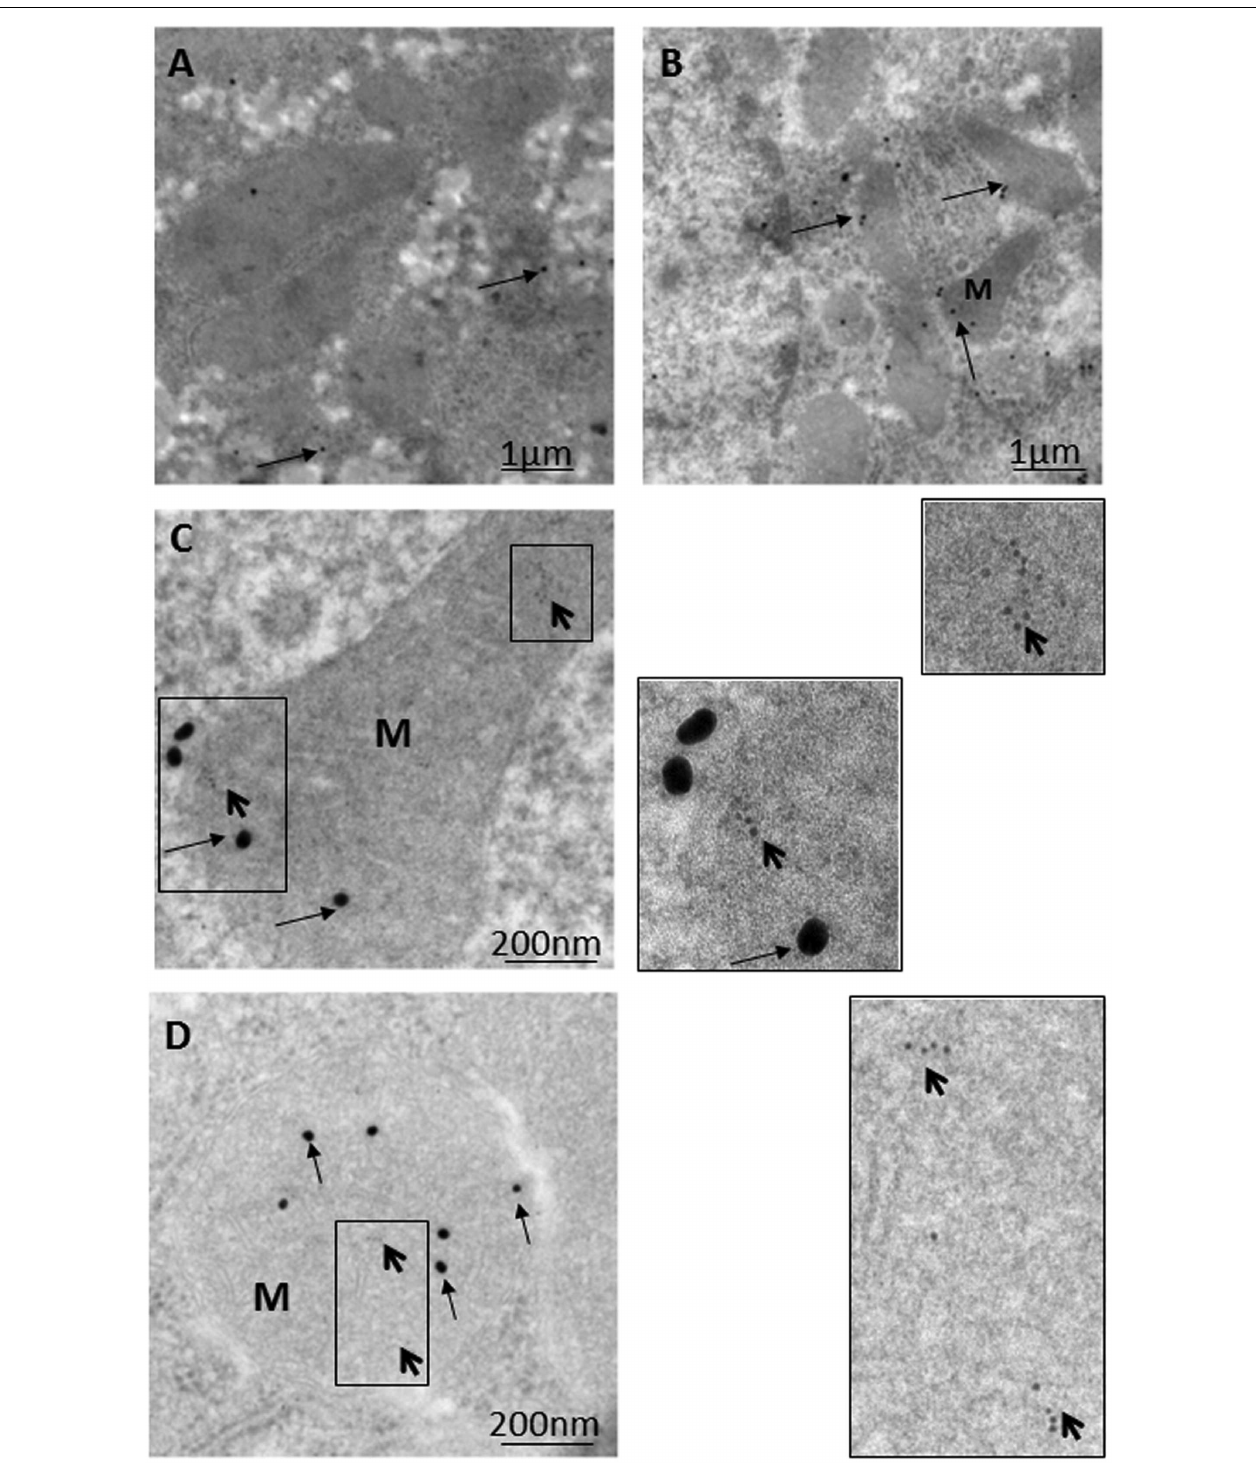
FIGURE 2 | Parkin translocation to mitochondria and mitophagosomes with accumulated 8-OHdG in hepatocytes of ETRs. (A) Control while (B–D) , ETRs. The boxed areas in C and D are magnified on the right. The long and short arrows indicate Parkin (25 nm) and 8-OHdG (6 nm) immunogold particles, respectively. M, mitochondrion. The method of post-embedding immunogold double labeling of Parkin (NB100-91921) and 8-OHdG (N45.1) was performed according to the manufacturer’s protocols (Aurion, Wageningen, Netherlands; http://www.aurion.nl/products/gold_sols.php) and recent publications (Eid et al., 2013a,